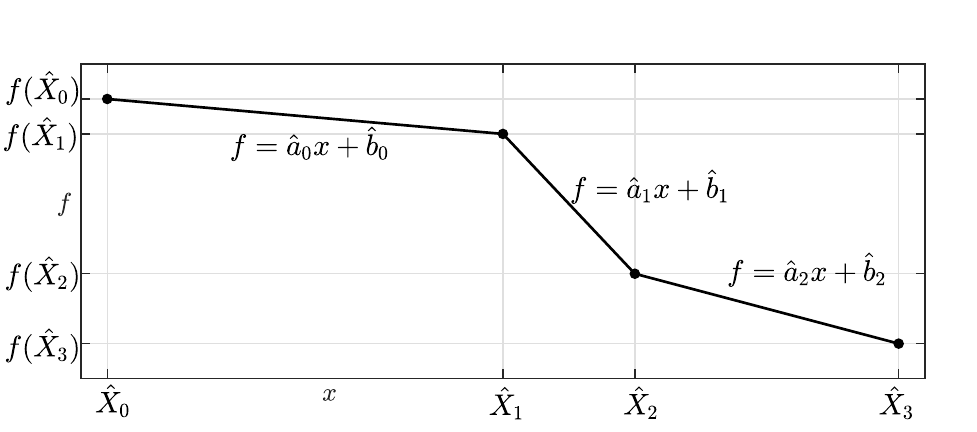
Figure A1. Example of the piecewise-affine (PWA) function f ( x ) with m =